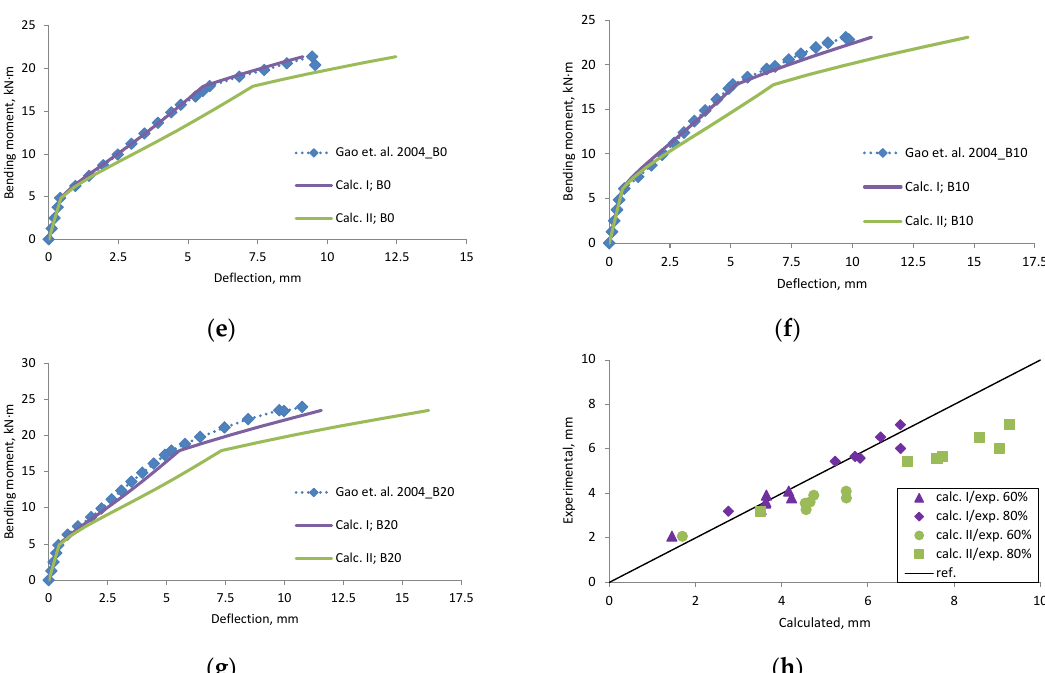
Figure A6. Gao et al., 2004 [29] research beams deflection compared with calculated, ( a ) beam CON1; ( b ) beam A0; ( c ) beam A10; ( d ) beam A20; ( e ) beam B0; ( f ) beam B10; ( g ) beam B20; ( h ) scatter of the results at 60% and 80% of the ultimate load.